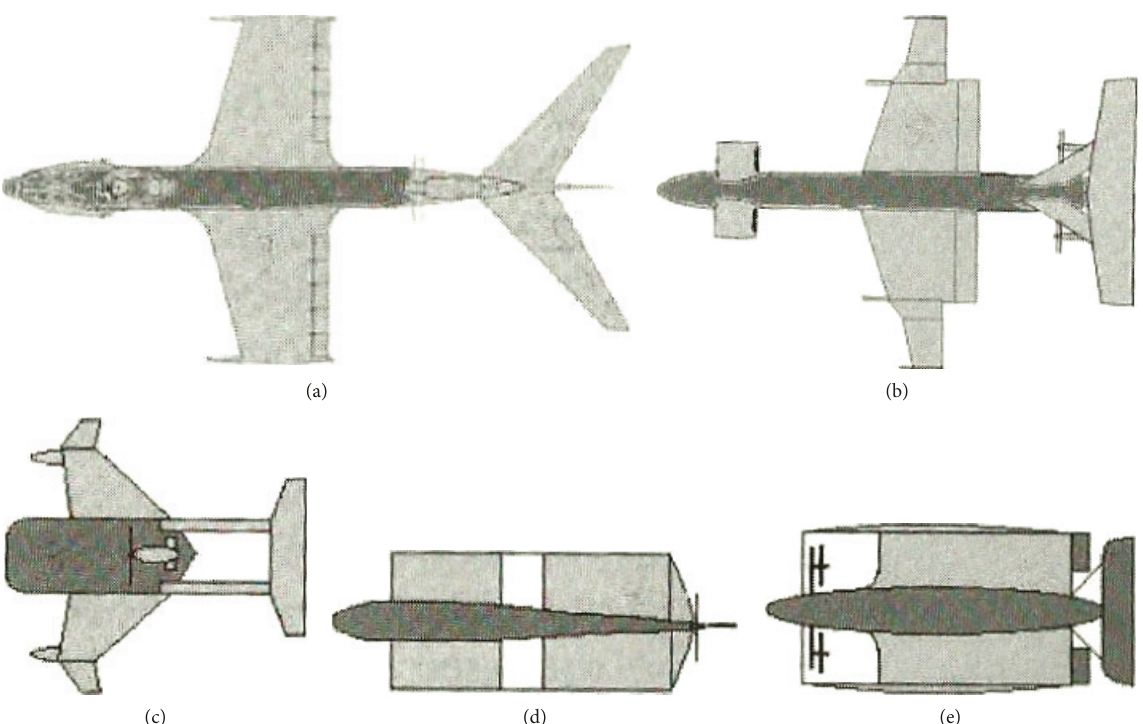
Figure 1: Typical wing arrangements of the wing in the ground e ff ect craft [3]: (a) airplane type, (b) composite wing, (c) Lippish type, (d) tandem, (e) Volga